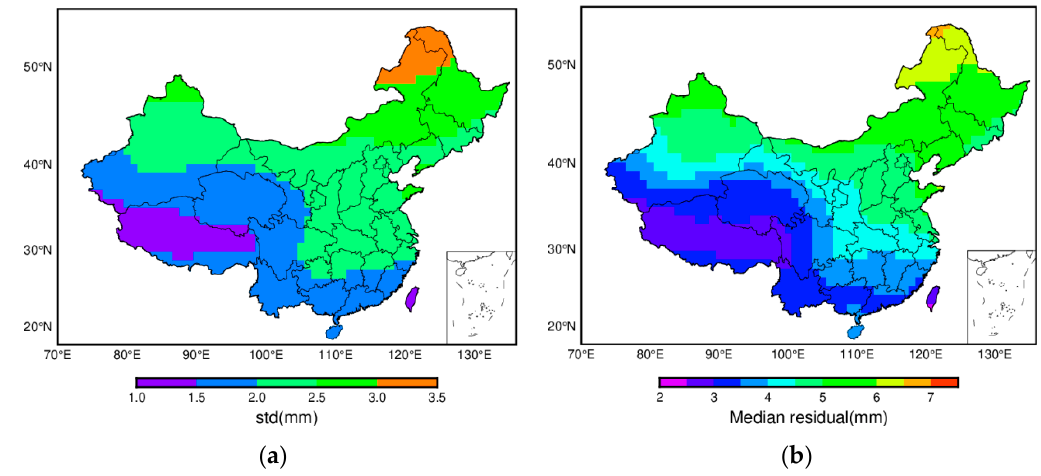
Figure 5. Standard deviations ( a ) and median ( b ) of residuals between daily and the monthly average.